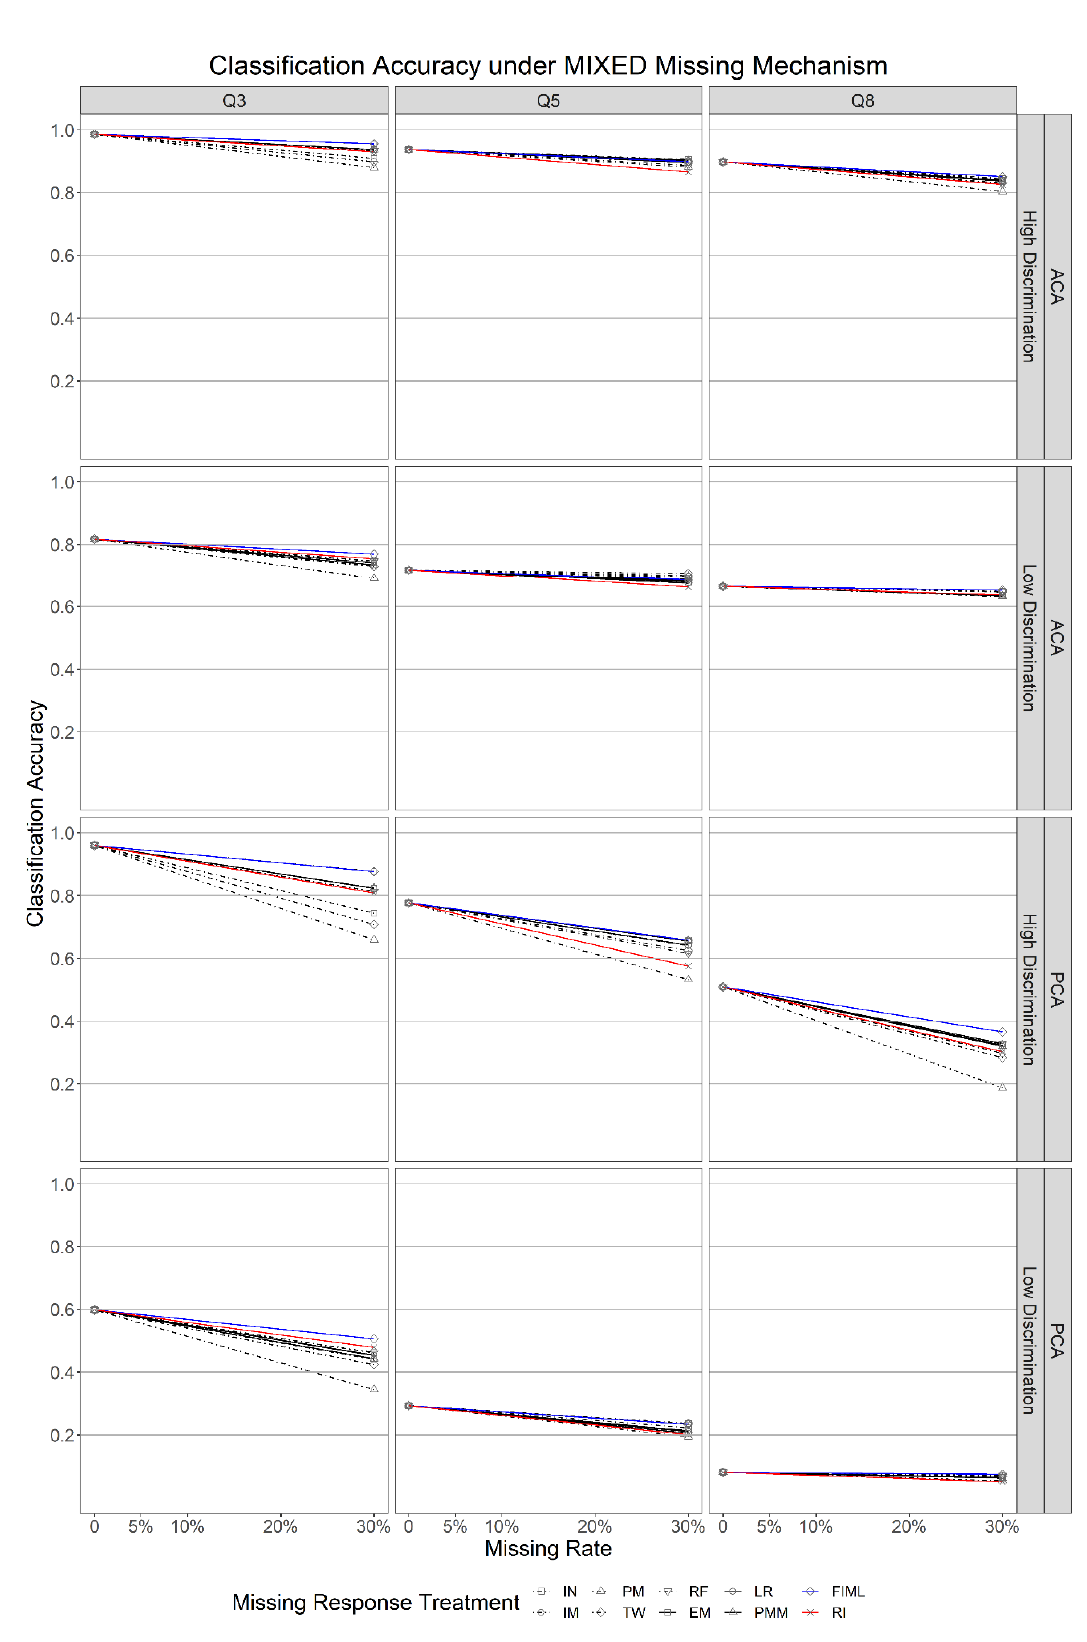
Figure 6. Classification accuracy under the MIXED missing mechanism. Columns Q3, Q5, and Q8 present results for Q-matrices with three, five, and eight attributes, respectively, while rows refer to results across high and low discriminations for both guessing and slipping parameters.